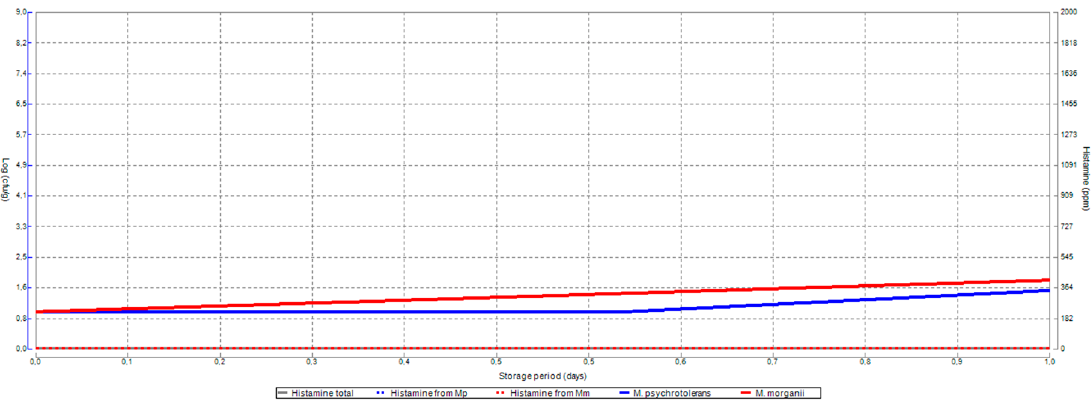
Figure 2. Application of FSSP in the case of insufficient